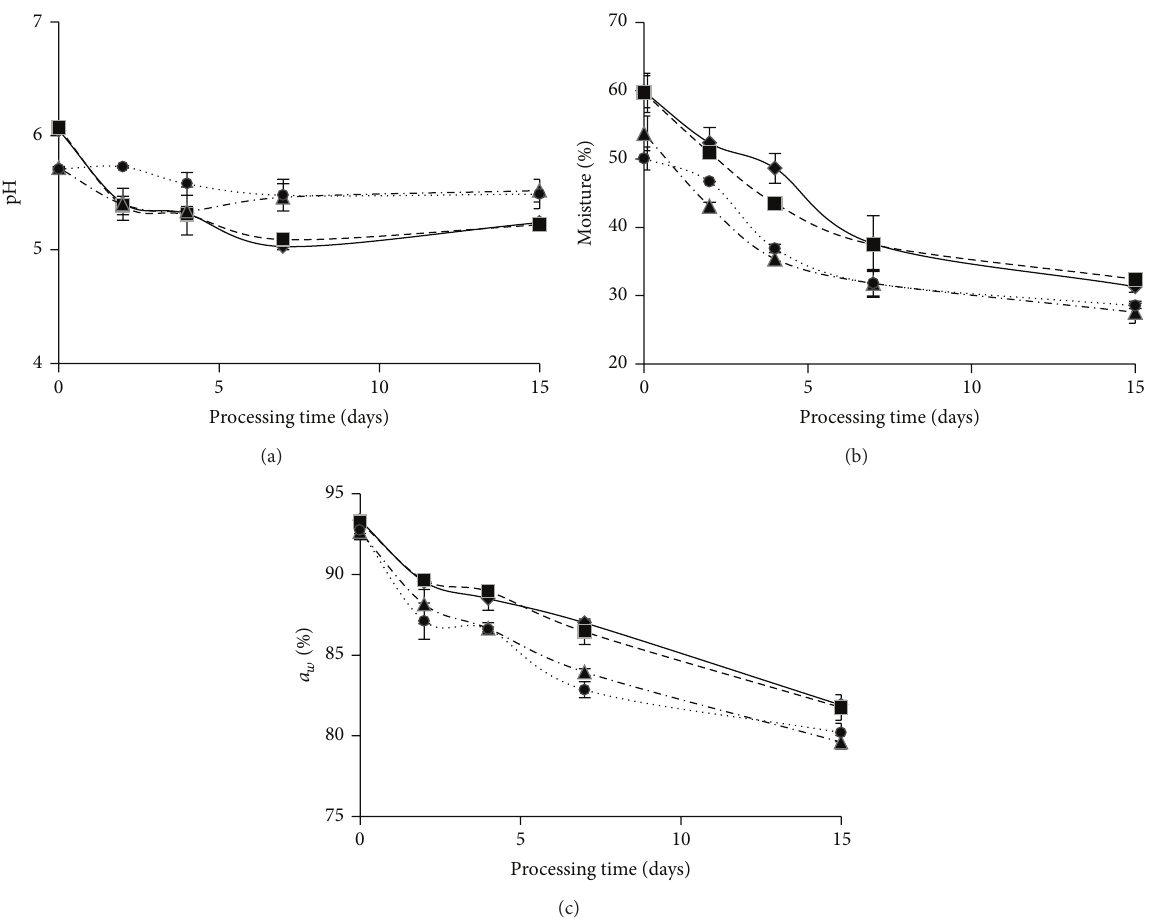
Figure 2: Physicochemical parameters determined during dry sausages fermentation and ripening periods. (a) pH values; (b) humidity (%); (c) 𝑎 𝑤 (%). Systems: X - X : SAS-1 ( Lactobacillus sakei 487 + Staphylococcus vitulinus C2); ◼ --- ◼ : C-1 (noninoculated control system simultaneously manufactured with SAS-1); 󳵳 - ⋅ - 󳵳 : SAS-2 ( L. sakei 442 + S. xylosus C8); e ⋅⋅⋅ e : C-2 (noninoculated control system simultaneously manufactured with